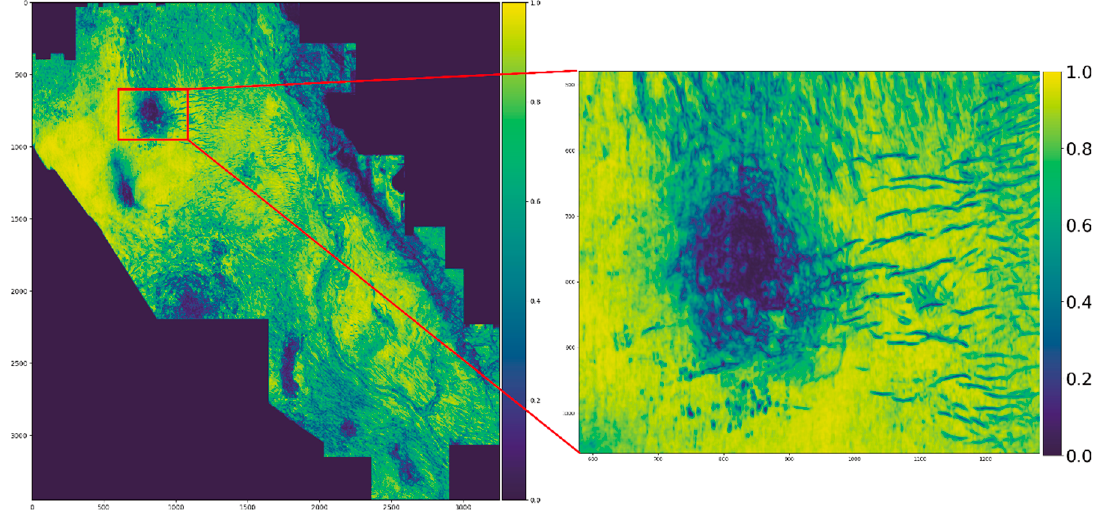
Figure 8. The coherence values at T40 and the near E–W trending fractures